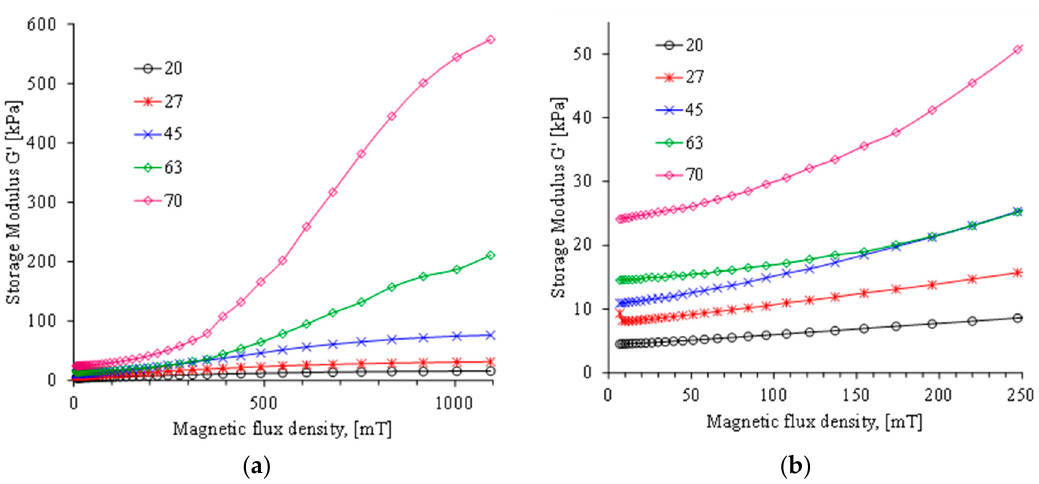
Figure 15. ( a ) Storage modulus behavior for the MRE material samples with 20, 27, 45, 63, and 70 wt % under the action of a variable magnetic flux density from 0 to 1093 mT. ( b ) Detailed view of the material behavior for magnetic flux density range from 0 to 250 mT.